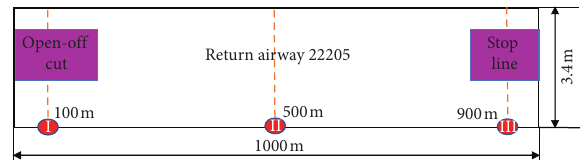
Figure 8: Layout of tunnel monitoring